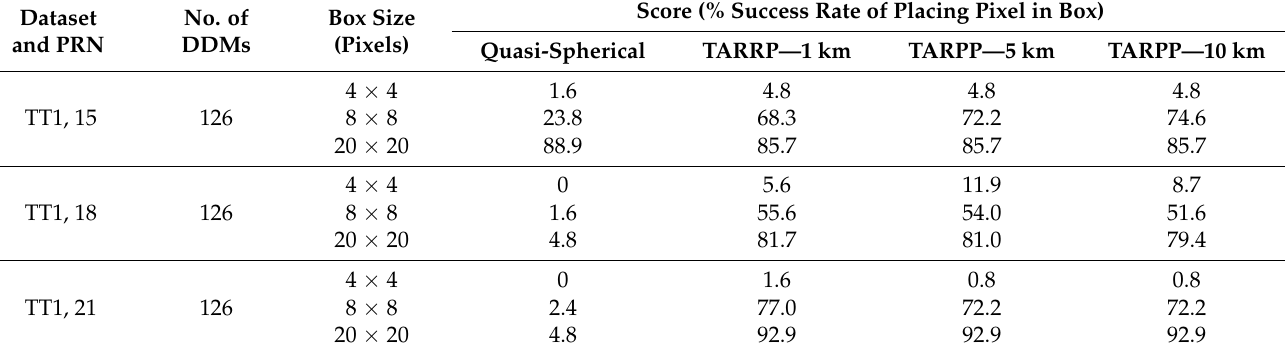
Table 3. Results of Analysis 2 on the TT1 dataset.